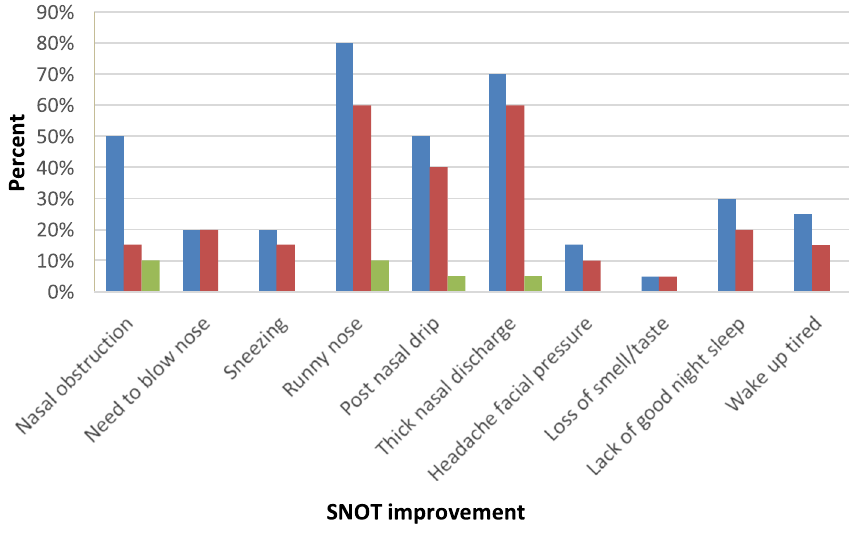
Fig. 9 Comparison between the 3 study groups as regards improvement in SNOT questionnaire after